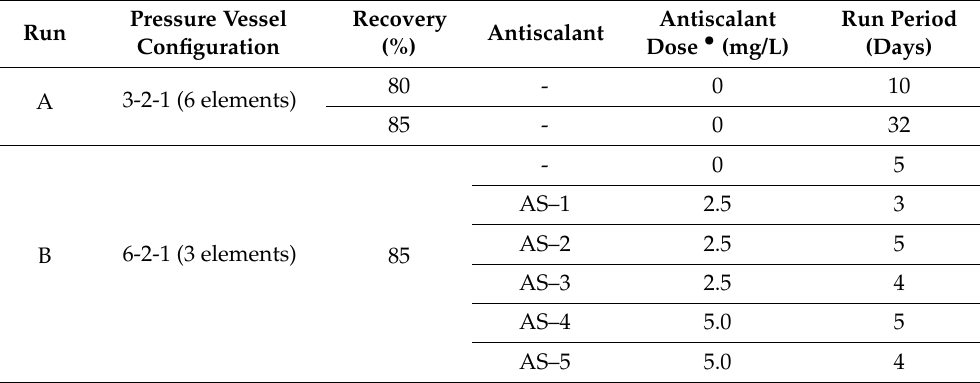
• Tested antiscalant doses were the suppliers’ recommended